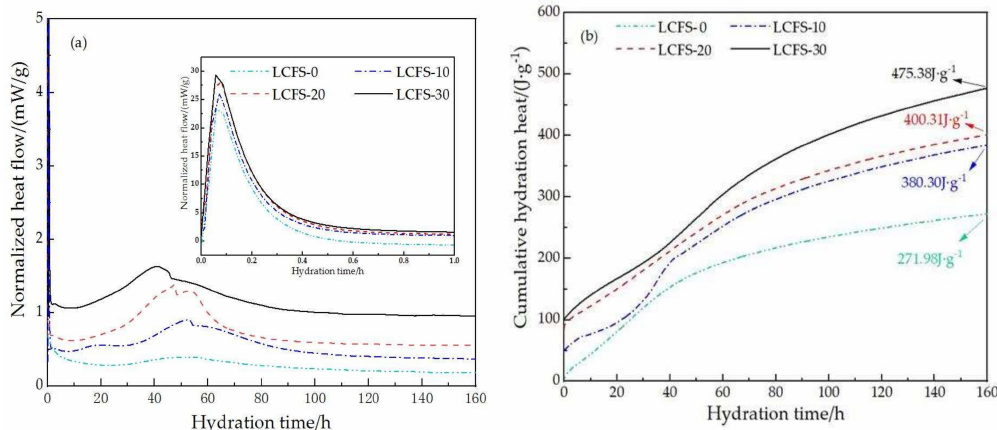
Figure 9. The hydration heat of paste samples: ( a ) heat flow curves; ( b ) cumulative hydration